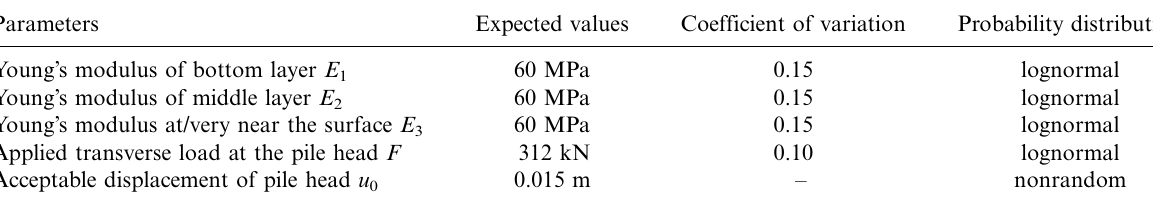
Table 1. Properties of applied variables of the first model